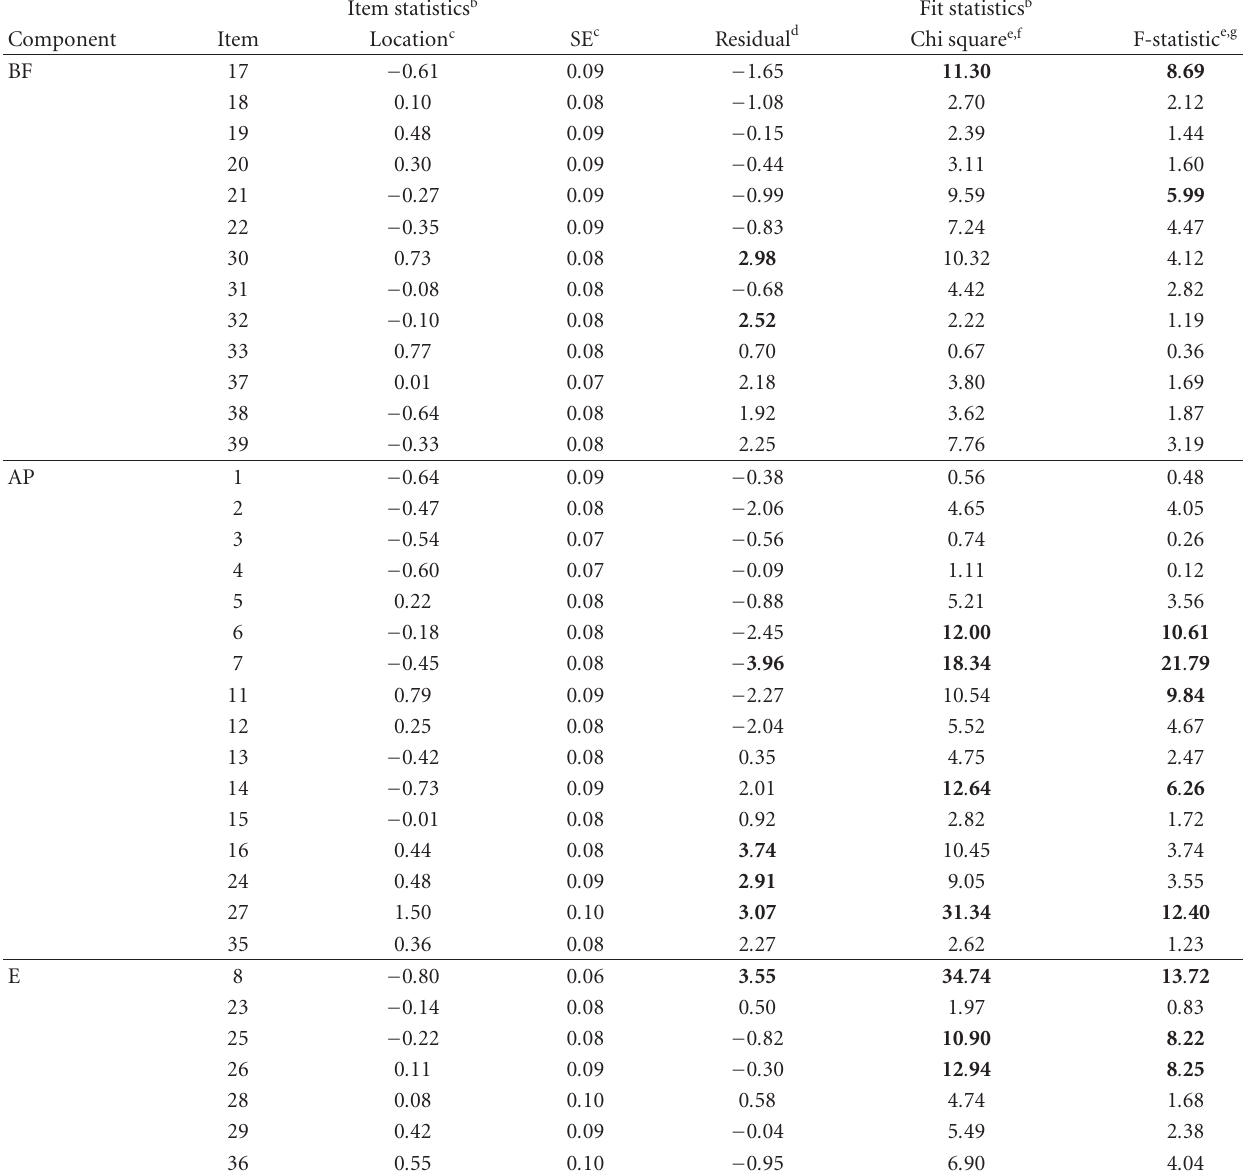
Table 3: Rasch item and fit statistics for the initial ICF scales of the PDQ-39 a . Item statistics b Fit statistics